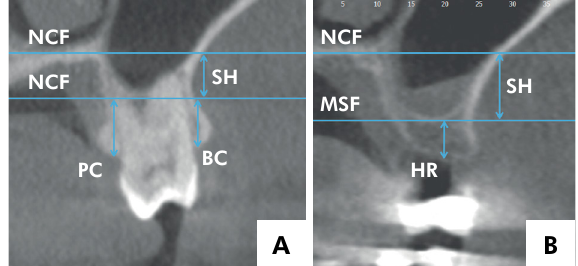
SH: Linear distance from nasal cavity floor to lowest level of the maxillary sinus floor (MSF) (3a, 3b); PC: linear distance from the buccal crest in TS (3a); HR: linear distance from the maxillary sinus floor to lowest point of alveolar crest in EdS (3b). Figure 3. Transaxial